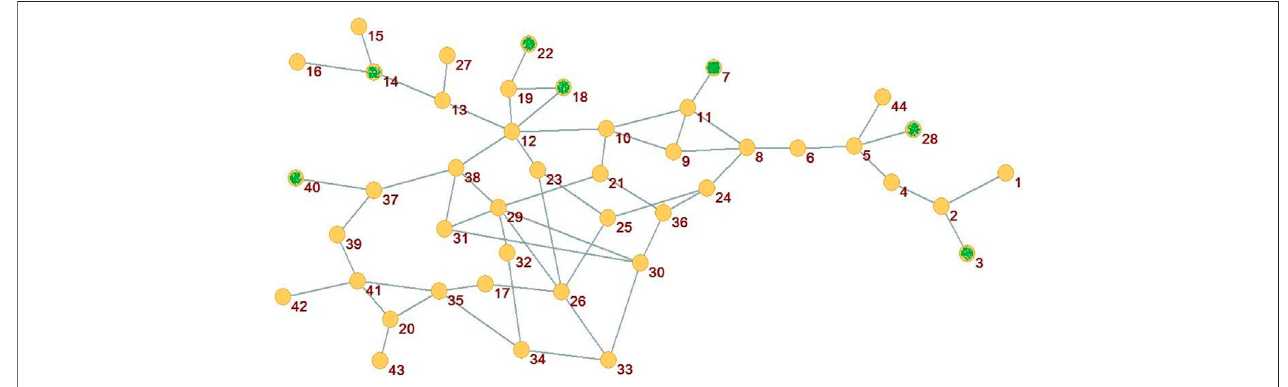
FIGURE 7 | The complex network model diagram of natural gas pipeline network.